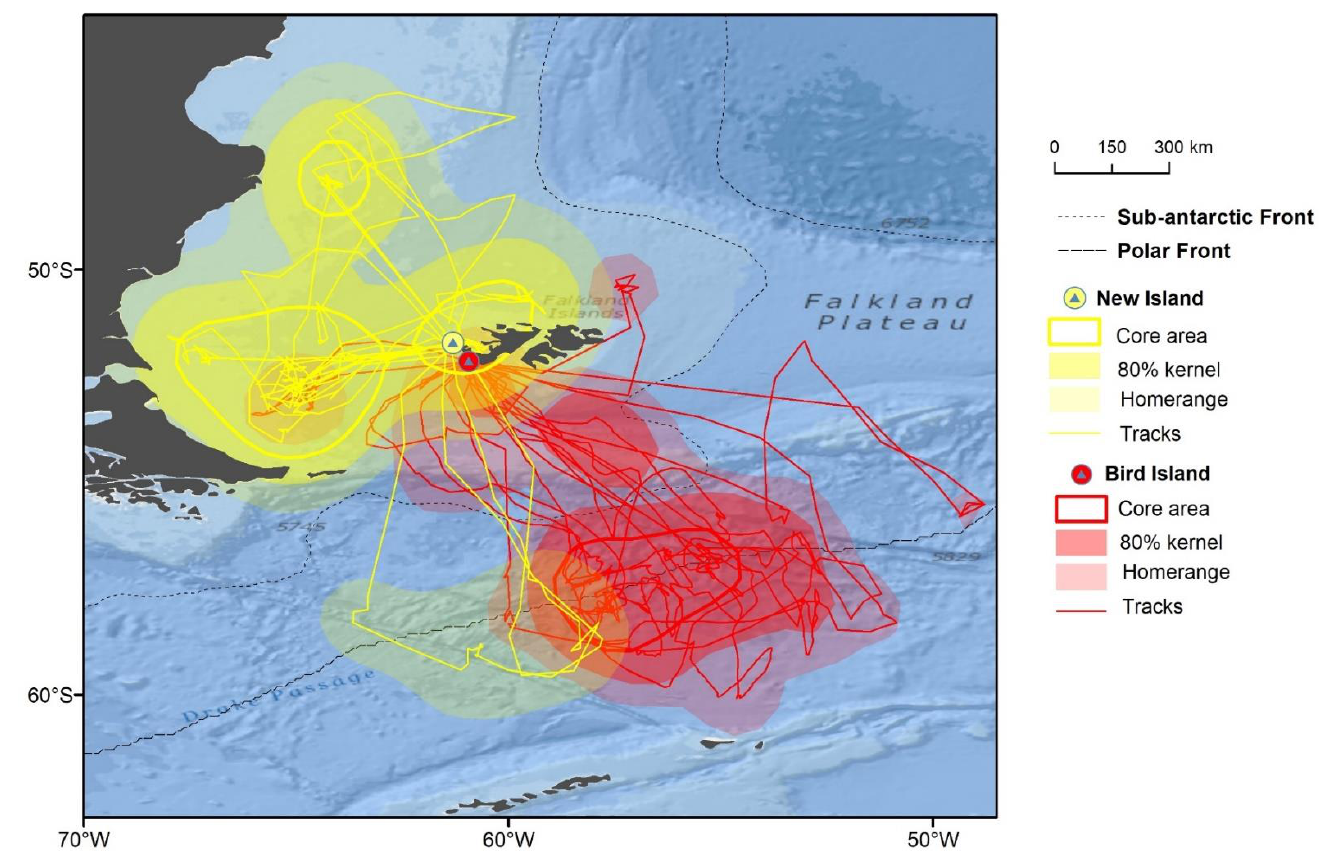
Figure 4. Tracks and main foraging areas (obtained by kernel analysis) of Thin-billed Prions from New Island and Bird Island during incubation in the season 2021 – 22.